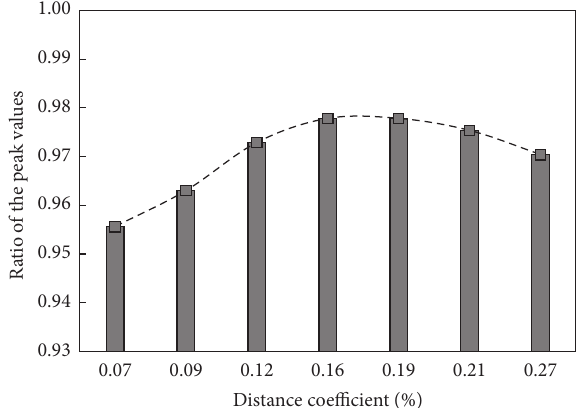
Figure 6: Ratios of the peak values of the modeled offshore platform with and without bufferable TMD for various distance coefficients under sinusoidal